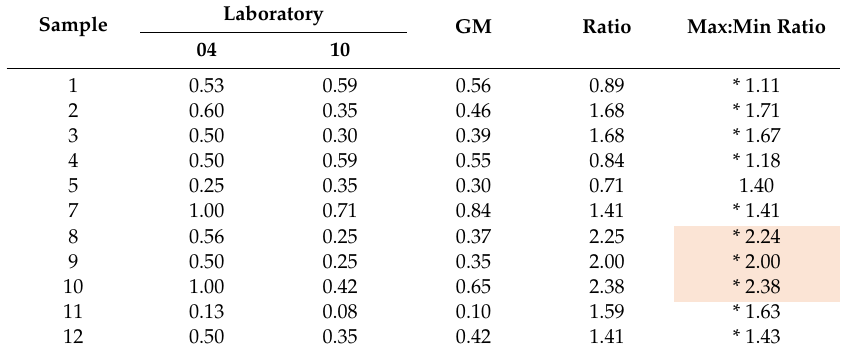
Table 5. Geometric mean potency estimates relative to Sample 6—Virus Neutralization assays.